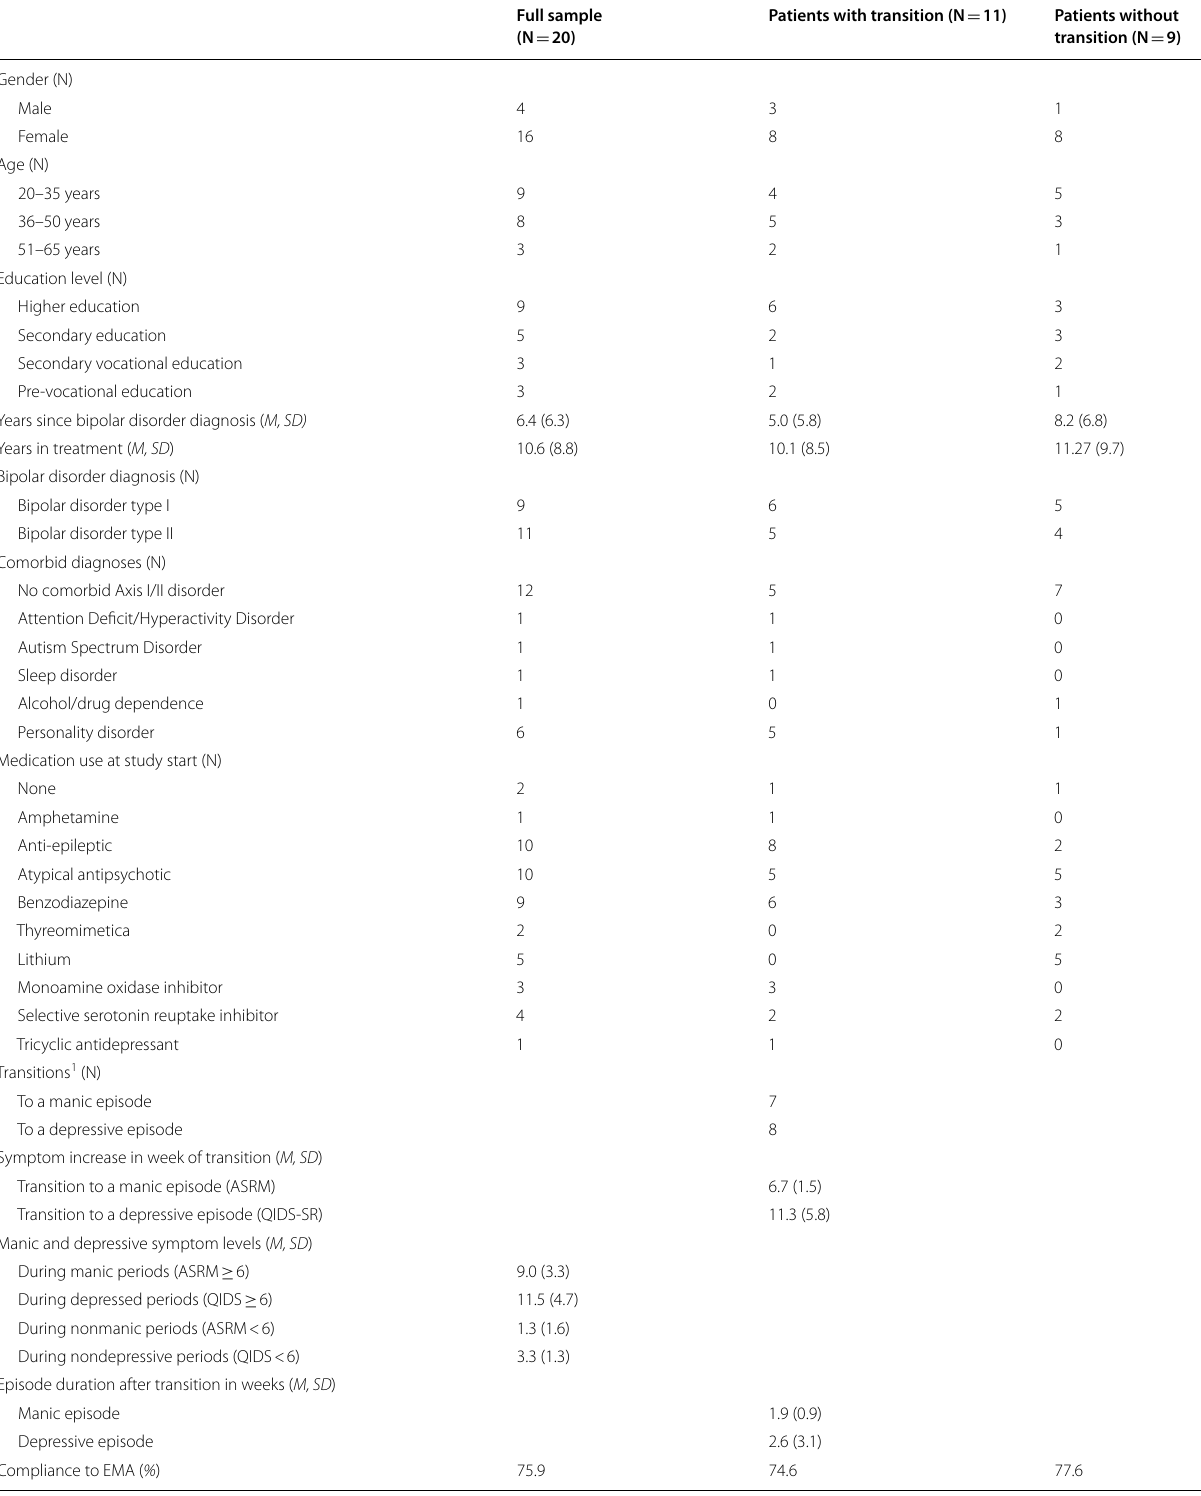
Table 1 Demographic and clinical characteristics